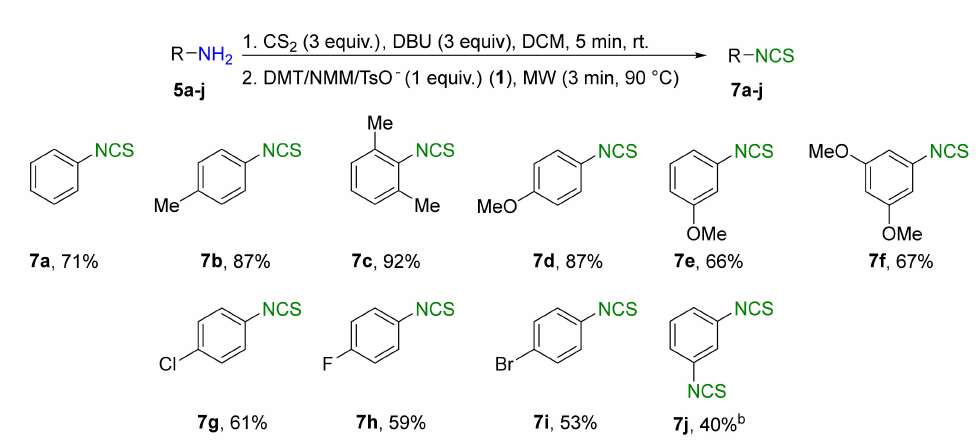
Figure 4. Scope of aromatic isothiocyanates 7a–j a . a –conditions: amine 5a – j (2 mmol), DBU (3 equiv., 6 mmol), CS 2 (3 equiv., 6 mmol), DCM (3 mL), first step 5 min, rt, then DMT/NMM/TsO − ( 1 ) (2 mmol, 1 equiv.); MW irradiation in standard mode 3 min, 90 ◦ C. Yield of products isolated after flash chromatography (hexane); b –conditions: amine 5j (2 mmol), DBU (6 equiv. 12 mmol), CS 2 (6 equiv. 12 mmol), DCM (5 mL), DMT/NMM/TsO − ( 1 ) (4 mmol, 2